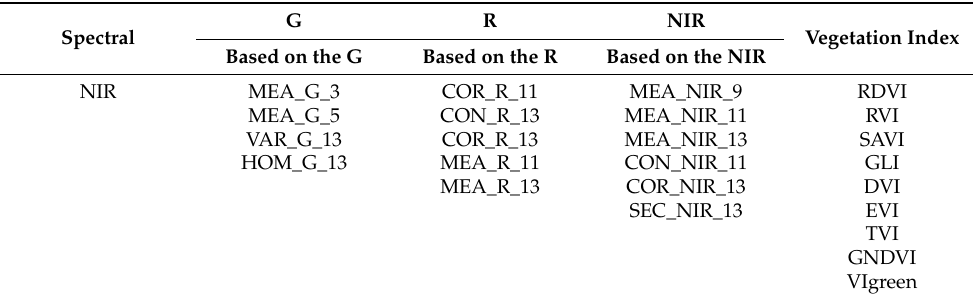
Table 5. Class-specific and OA results of the three methods for “preferred features”. The values in this table correspond to the classification results in Figure 6. Table 4. Top 25